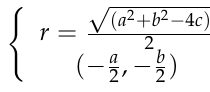
Figure 12. Pixel edge extraction.